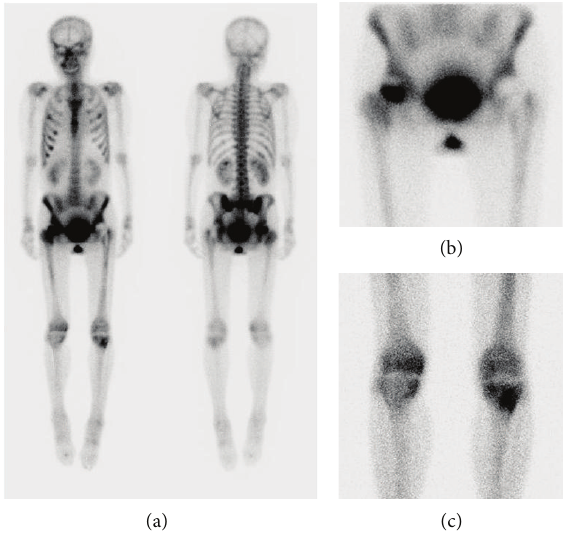
Figure 2: Bone scintigram showed the abnormal uptake in the right hip (a, b) and the right and the left knee joints (a, c).